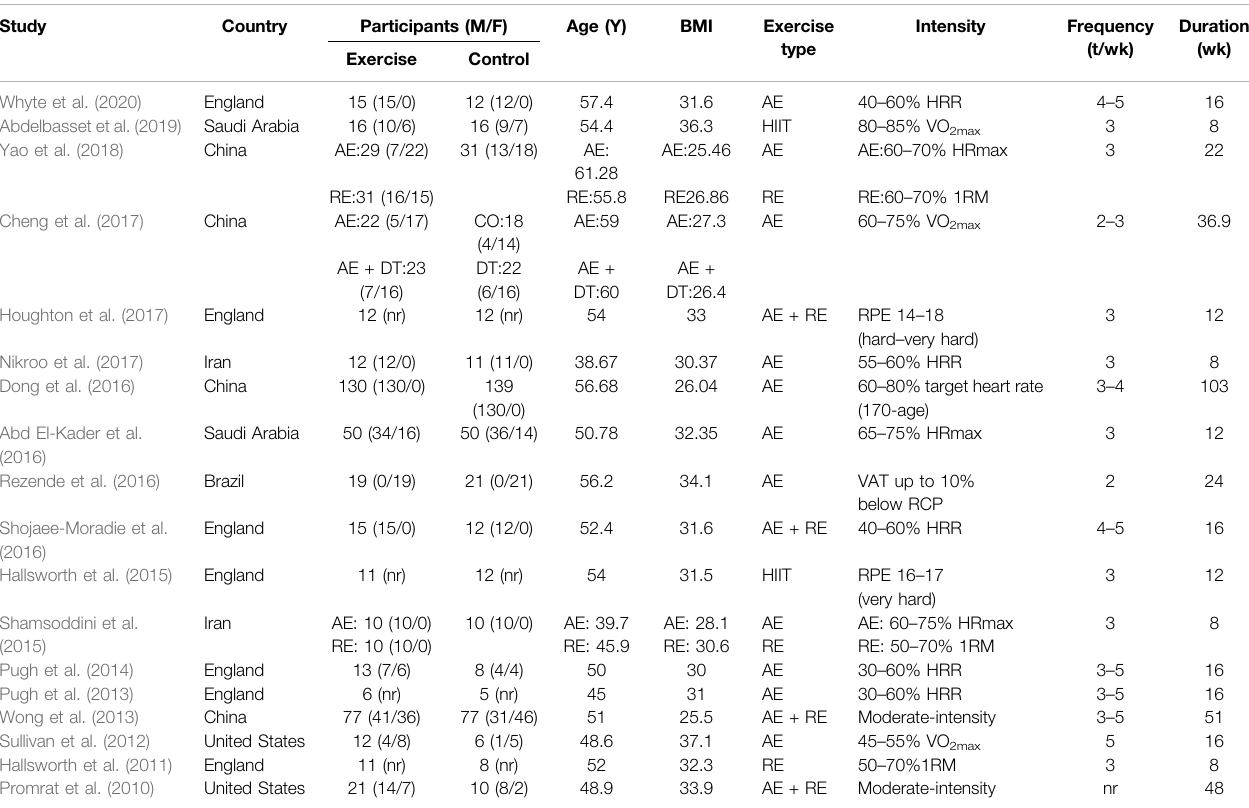
TABLE 1 | Characteristics of the included